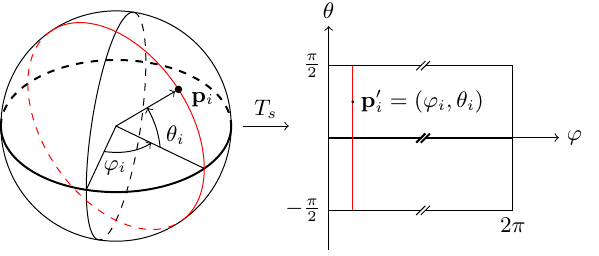
Figure 6: The equirectangular projection of a unit sphere.